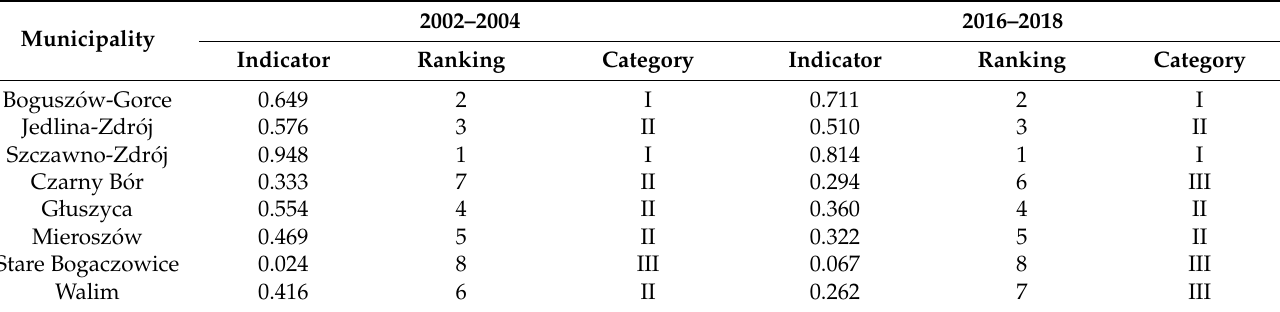
Table 5. Indicators of environmental development potential for Wałbrzych County municipalities calculated using zero unitarization